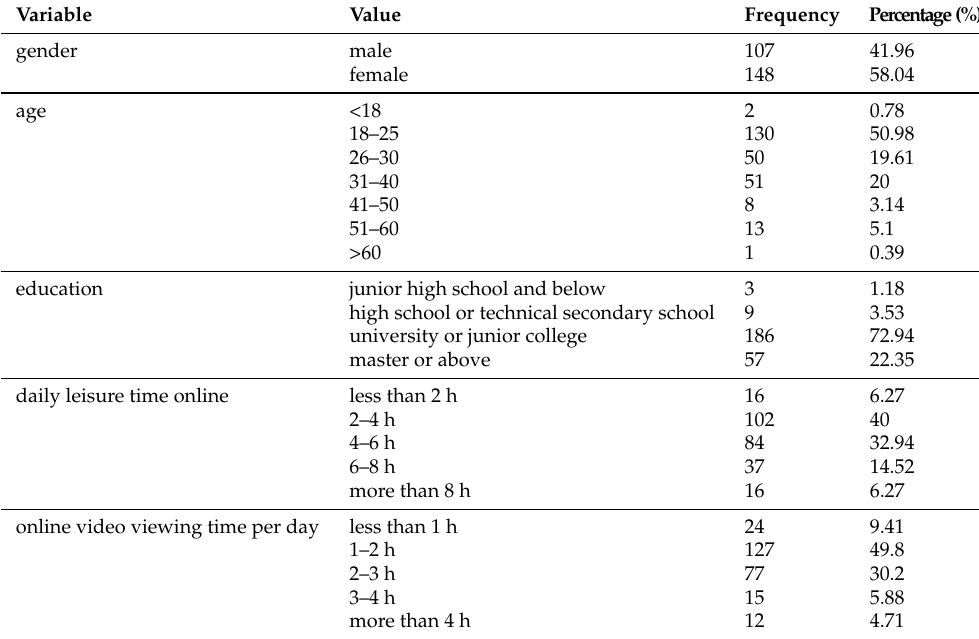
Table 2. Demographic